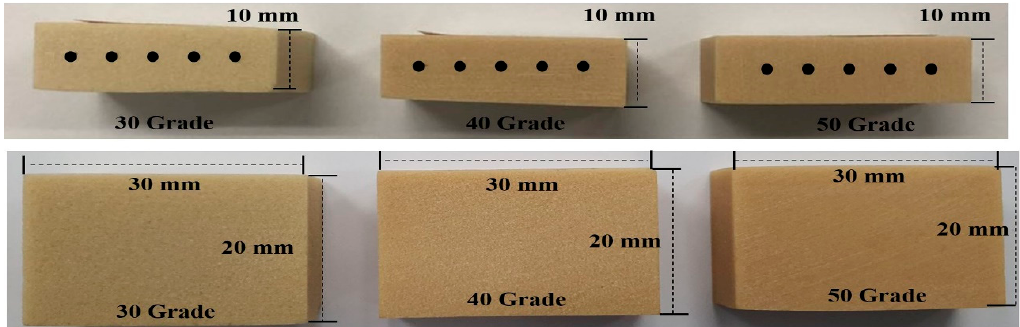
. . Figure 3. Different types of artificial bone used in the study. Figure 3. Di ff erent types of artificial bone used in the study. Figure 3. Different types of artificial bone used in the study. Figure 3. Different types of artificial bone used in the study.